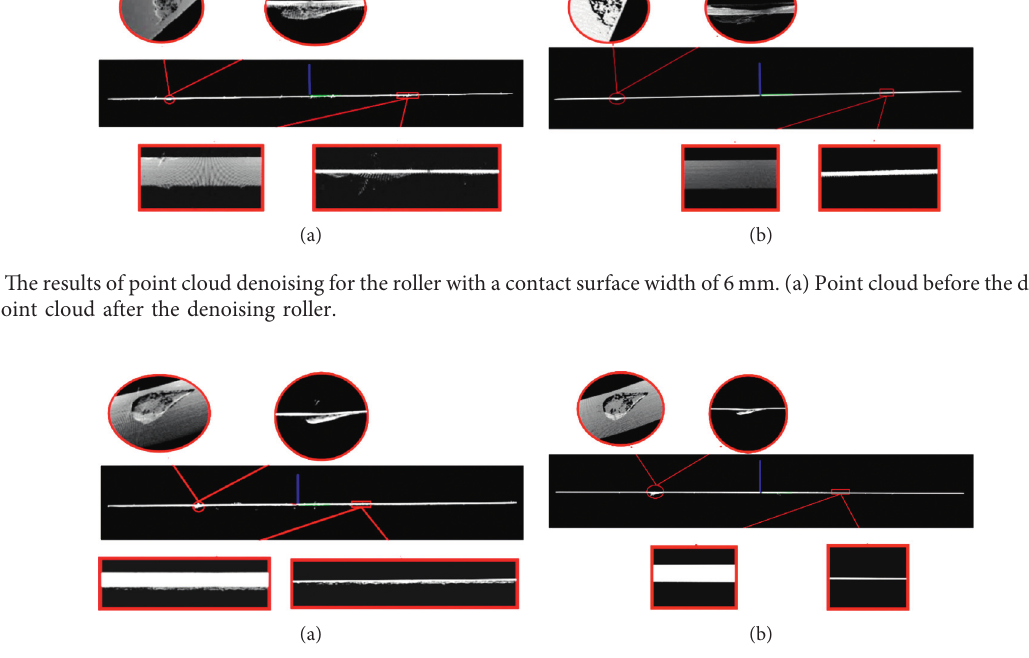
Figure 8: The results of point cloud denoising for the roller with a contact surface width of 10mm. (a) Point cloud before the denoising roller and (b) point cloud after the denoising roller.